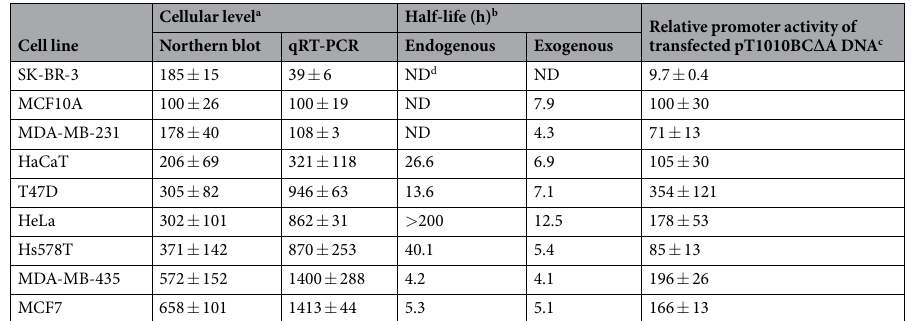
Table 1. Cell-specific features in BC200 RNA biosynthesis. a Cellular levels of BC200 RNA were calculated from the data of Fig. 5B (for Northern blot) and Fig. 5C (for qRT-PCR). b Half-lives of BC200 RNA were determined by linear regression analysis from the data of Fig. 6A (for endogenous) and Fig. 6B (for exogenous). c Relative promoter activities were from the data of Fig. 8. d ND, not